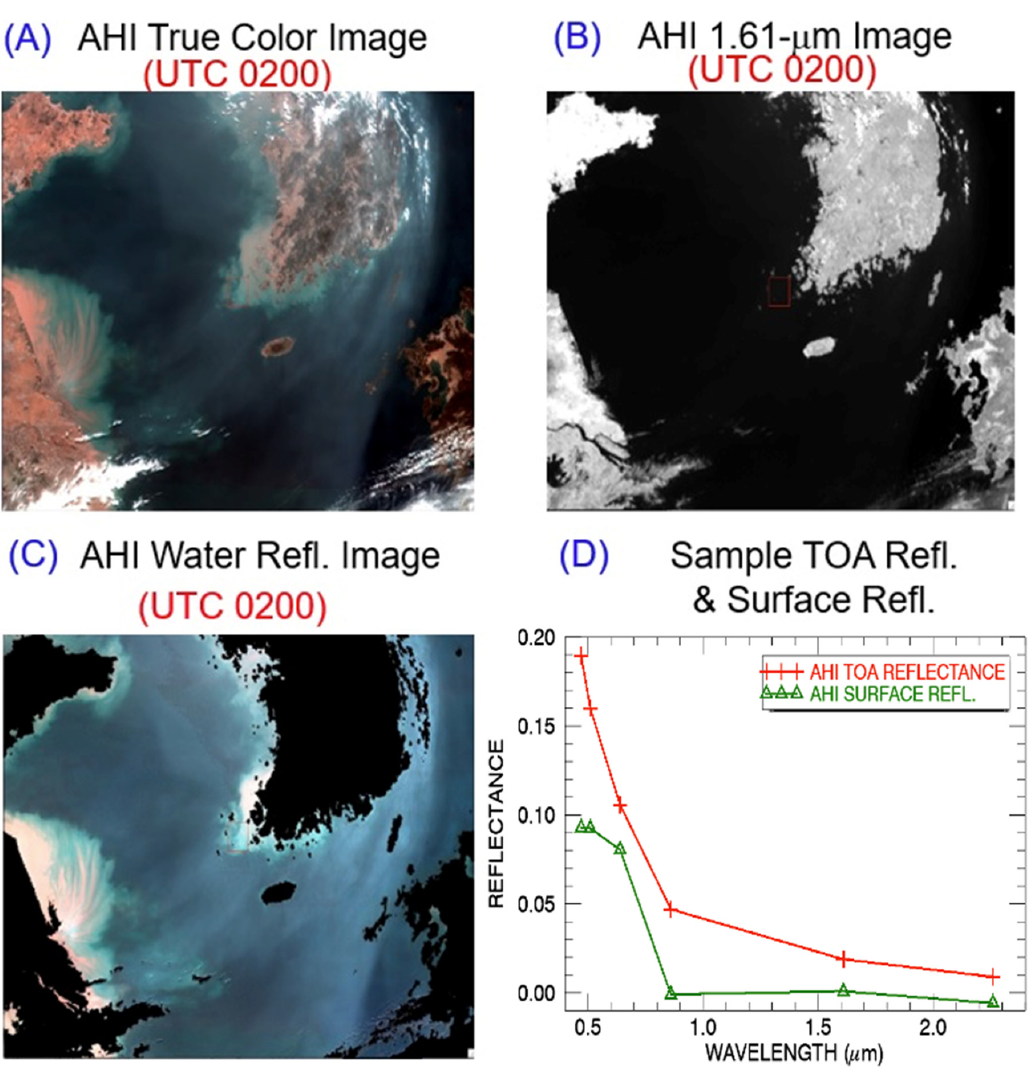
Figure 7. ( A )—a true color AHI image acquired at UTC 0200 on May 28, 2017 over part of Japan, Korea, and eastern China; ( B )—the 1.61- µ m AHI B / W image; ( C )—the retrieved true color water leaving reflectance image; and ( D )—spectral plot for a bright pixel for TOA apparent reflectances marked with the “ + ”symbols and for the corresponding surface reflectances marked with small diamonds.